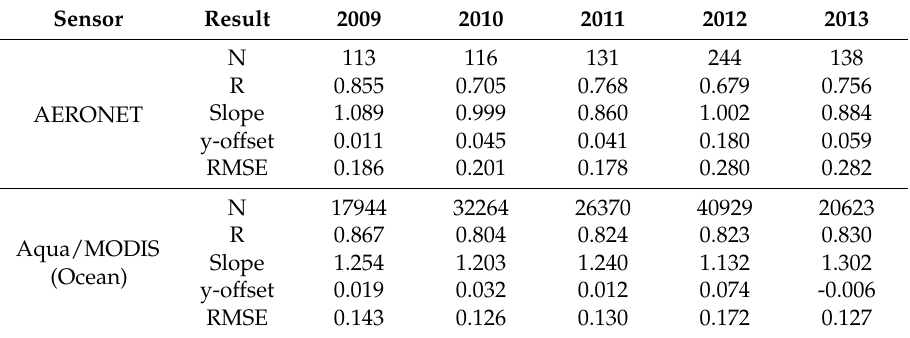
Table 6. Statistics for the comparison of AOD retrieved from TANSO-CAI aerosol algorithm and AERONET and Aqua/MODIS (ocean) observations from June 2009 to December